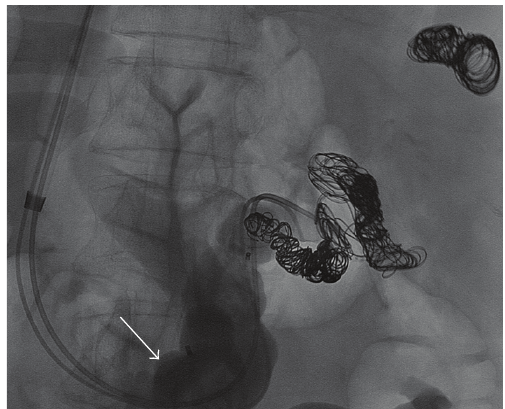
Figure 5: Catheter angiogram following coil and Gelfoam place- ment into the splenocaval shunt demonstrates draining collateral vessel (arrow) from the splenocaval shunt into the left renal vein, which was subsequently embolized with coils as